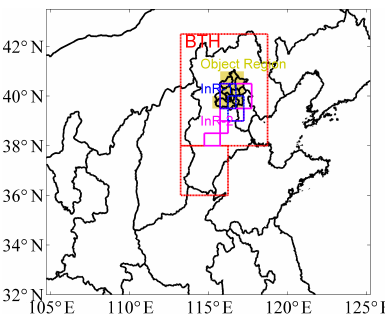
Figure 7. Different influential regions. BTH: red dashed frame; InR-1: blue dashed frame; InR-2: pinkish red solid frame; object region: yellow shadow.